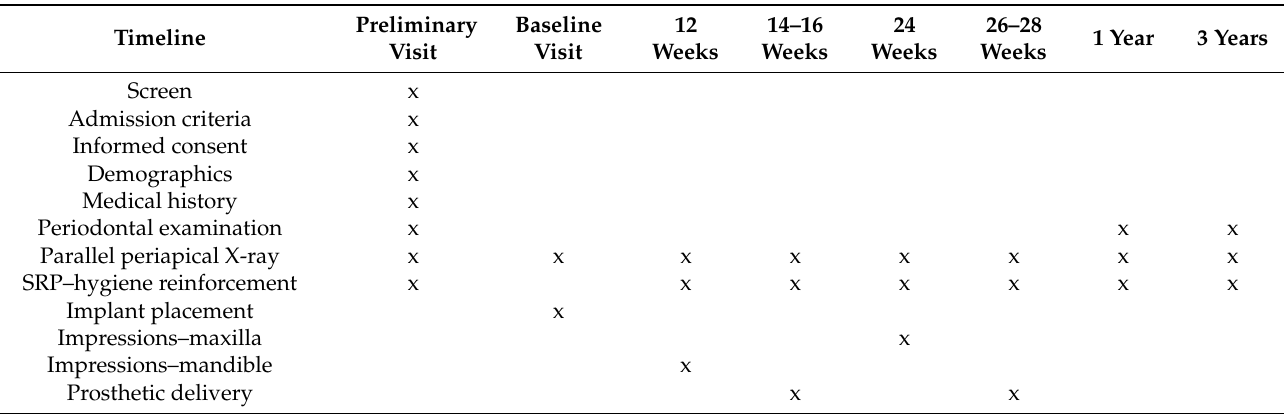
Table 1. Schematic outline of the